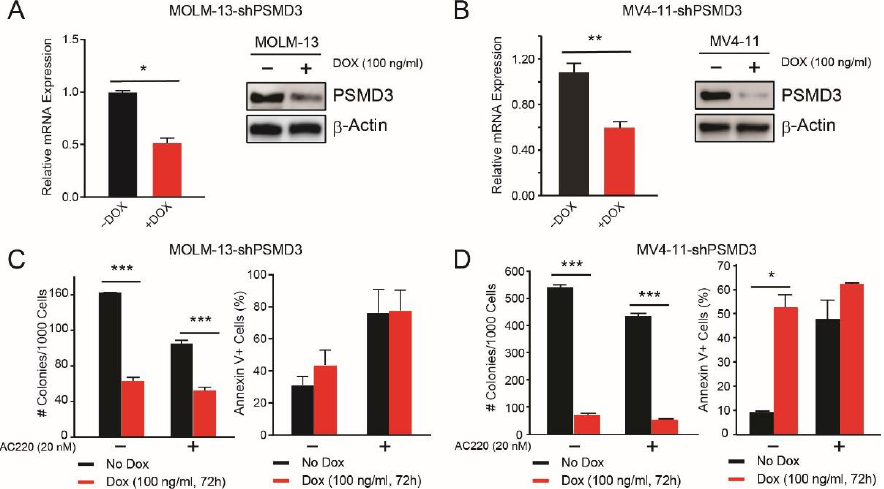
Figure 2. shRNA-mediated PSMD3 (shPSMD3) knockdown impaired survival of the FLT3-mutated AML cell lines, MOLM-13 and MV4-11, with variable effects on apoptosis. ( A , B ) Bar graphs and immunoblots show PSMD3 knockdown at the mRNA and protein level, respectively, in MOLM-13 ( A ) and MV4-11 ( B ) cells cultured with and without doxycycline (DOX, 100 ng/mL, 72 h). ( C , D ) Bar graphs show the effect of shPSMD3 on survival in colony formation ( left ) and late apoptosis ( right ) in MOLM-13 ( C ) and MV4-11 ( D ) cells cultured ± doxycycline (DOX, 100 ng/mL, 72 h) and ± quizartinib (AC220, 20 nM, 72 h). Error bars represent SEM (* p < 0.05; ** p < 0.01; *** p < 0.001). To confirm these data using an in vivo model, we intravenously injected 3 × 10 6 shNT-